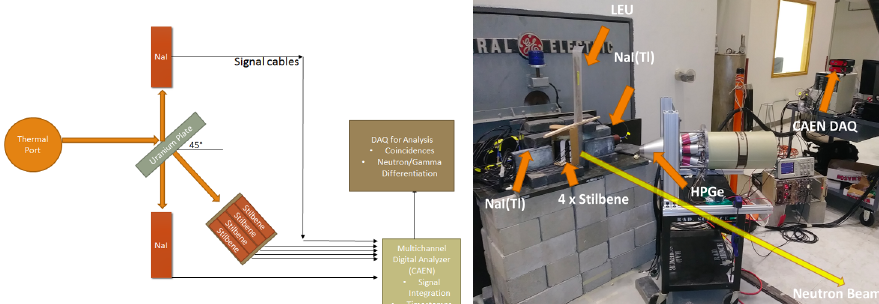
Fig. 2. The physical layout of the fission